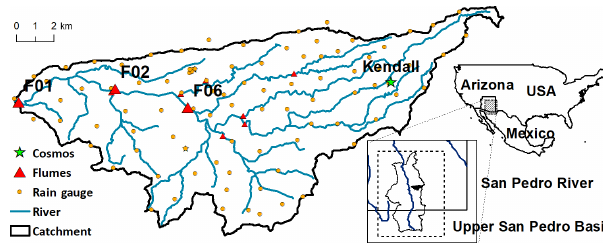
Figure 5. Geographic location of the Walnut Gulch Experimental Watershed and the location of monitoring